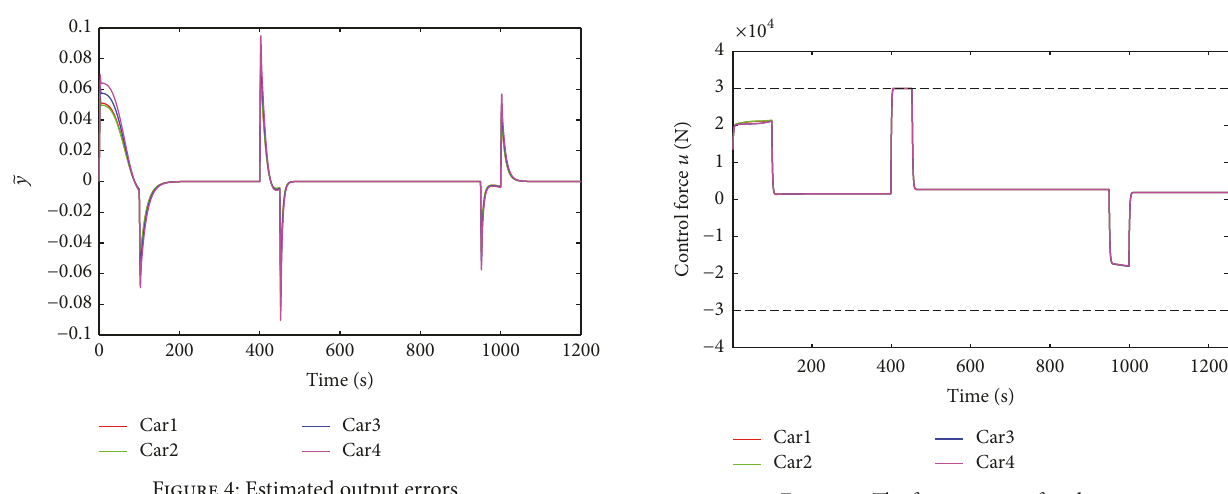
Figure 5: The force output of each